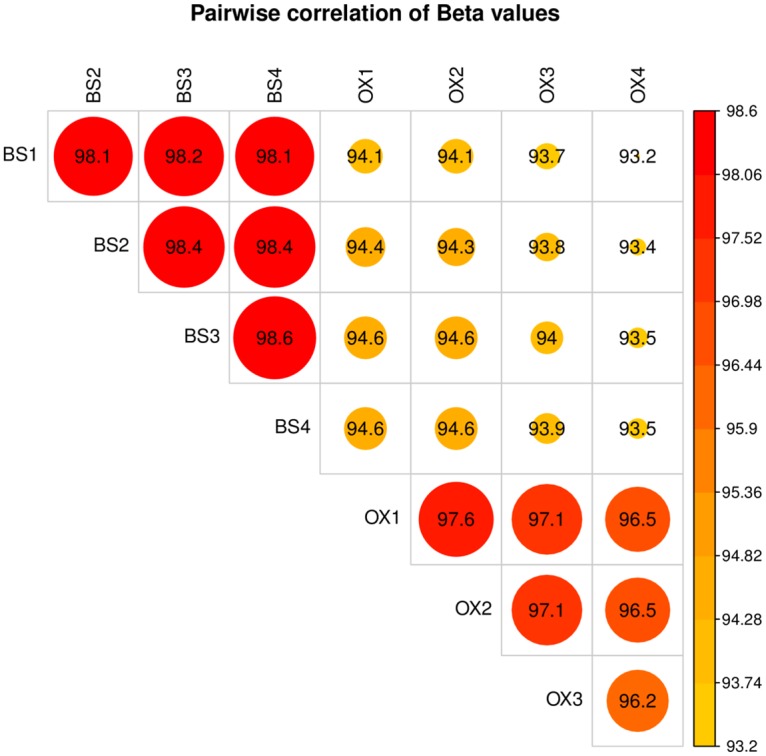
Pairwise correlation in beta values between BS and oxBS arrays.The same sample was divided into four BS and four oxBS replicates. Beta values are generated by the minfi analysis package and represent the percentage of unconverted C’s at any given locus. The average correlation of BS replicates is 98.3 and of the oxBS replicates is 96.8. The average correlation between the two methods is 94.0.